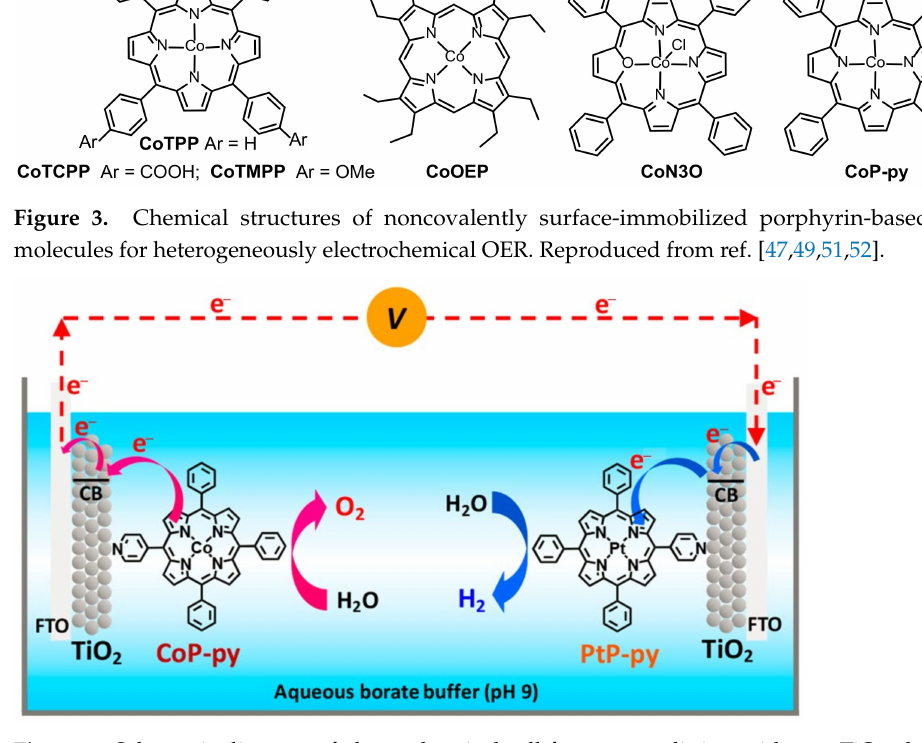
Figure 4. Schematic diagram of electrochemical cell for water splitting with two TiO 2 electrodes containing CoP-py and PtP-py as molecular catalysts. Reprinted with permission from ref. [51]. Copyright 2020 American Chemical